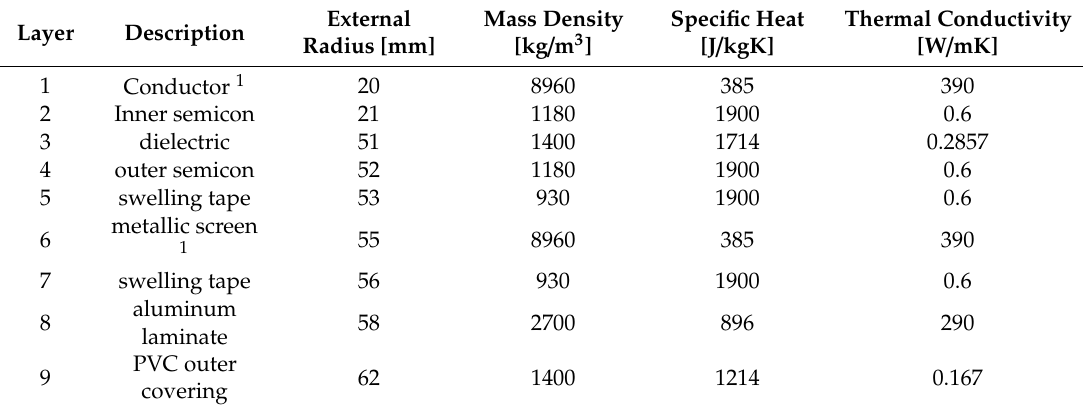
Table 1. Geometrical and physical properties of the cable taken as the case study.